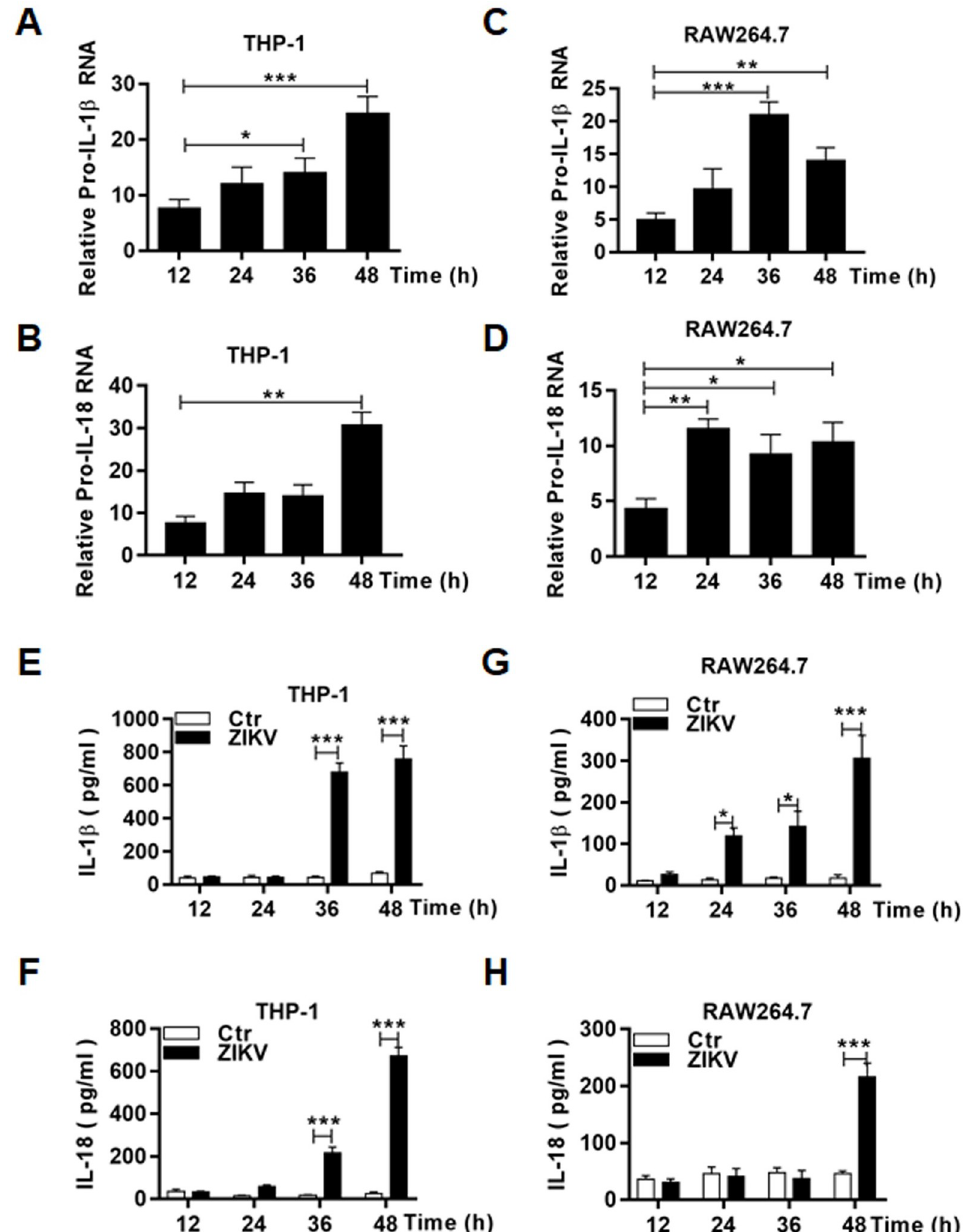
Fig 8. Transcriptional upregulation and secretion of IL-1 β and IL-18 in ZIKV-infected human and murine macrophages. Total RNA was prepared at various time points p.i. from THP-1 ( A-B ) and RAW264.7 ( C-D ) cells infected with 0.1 MOI of ZIKV for realtime RT-PCR to measure mRNA transcript numbers of pro-IL-1 β ( A & C ) and pro-IL-18 ( B & D ) genes. Culture medium was sampled at various time points p.i. from ZIKV-infected THP-1 ( E-F ) and RAW264.7 ( G-H ) cells for measurement of secreted IL-1 β ( E & G ) and IL-18 ( F & H ) by ELISA. The experiments were performed in triplicates and the data were shown as mean+SD and analysed by unpaired Students t-test. � , P < 0.05; �� , P < 0.01; ��� , P < 0.001. ns, no significance.